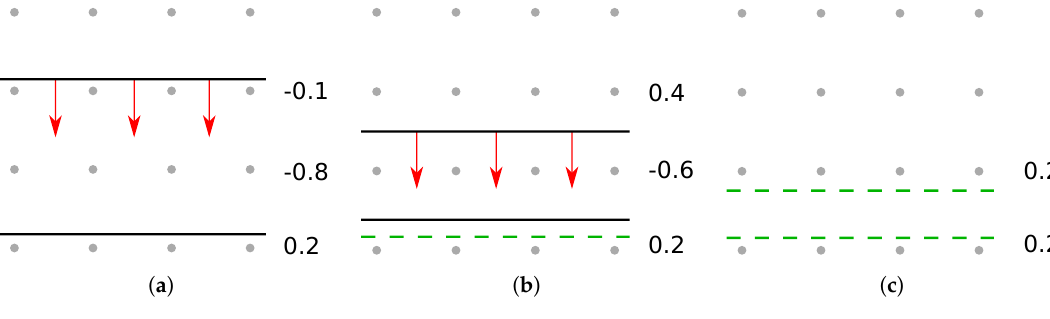
Figure 3. Top surface of a thin layer is moved until the layer disappears entirely. Grey points indicate the grid, black lines the surface, red arrows the movement per time step, and dashed green lines the correct position of the surface. The level set values of each row are shown to its right. ( a ) Initial layer, only two grid spacings wide, whose top surface is moved downwards. ( b ) As the layer is thinned to only one grid point, the level set values are not normalized anymore, resulting in symmetric shrinking. ( c ) Once the last row of grid points is outside of the layer, it ceases to exist, although it should still be almost one grid spacing